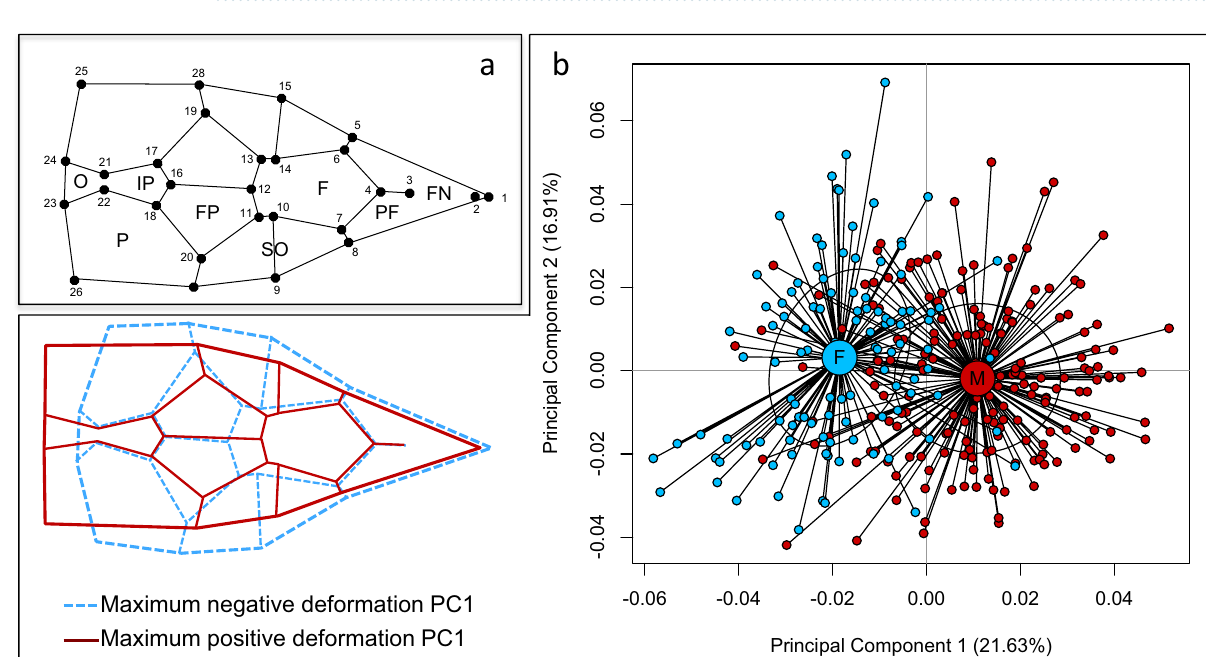
Figure 2. Head shape sexual dimorphism. ( a ) Localization of the 28 landmarks recorded on the head of Podarcis siculus . Solid black lines: mean shape among all individuals. Nomenclature of scales: F: frontal, FN: frontonasal, FP: frontoparietal, IP: interparietal, N: nasal, O: occipital, P: parietal, PF, prefrontal, SO: supraocular. ( b ) Principal Component Analysis (PCA) on Procrustes shape coordinates, with 38% of total variance accounted by the first two PCs. Schematic representation of landmark deformations on the first PC reconstructed from grids and vectors (exaggeration factor of 2). Solid red lines: male maximum deformation, dashed blue lines: female maximum